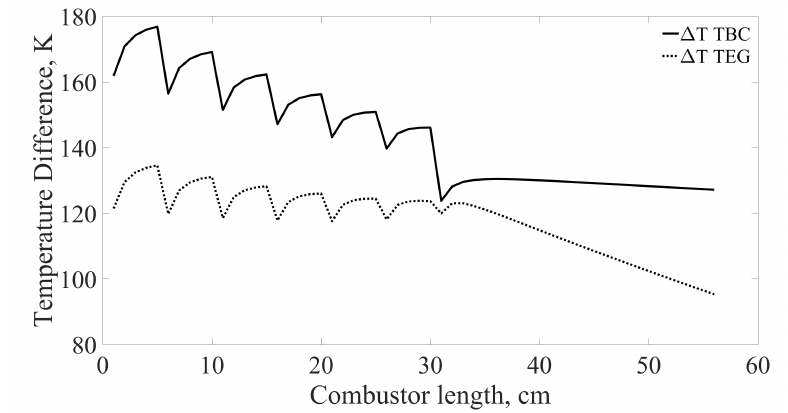
Figure 9. Temperature difference across the ceramic heat shield and the TEG along the length of the combustor, for the case TEGs made of Si . Fill factor: 21%, L TEG :0.0011 m, I: